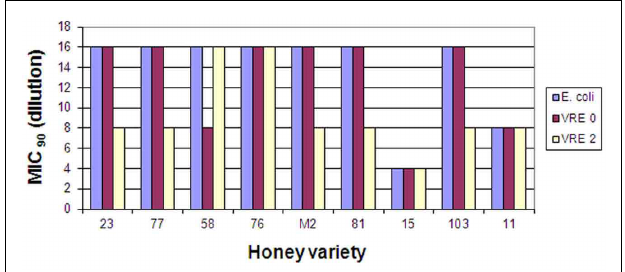
FIGURE 1 | Bacteriostatic activity of eleven honey varieties against two clinical isolates of vancomycin-resistant Enterococcus faecium strains, VRE 0 andVRE 2. Reproducibility for each strain was determined at minimum in three separate experiments conducted in triplicate.